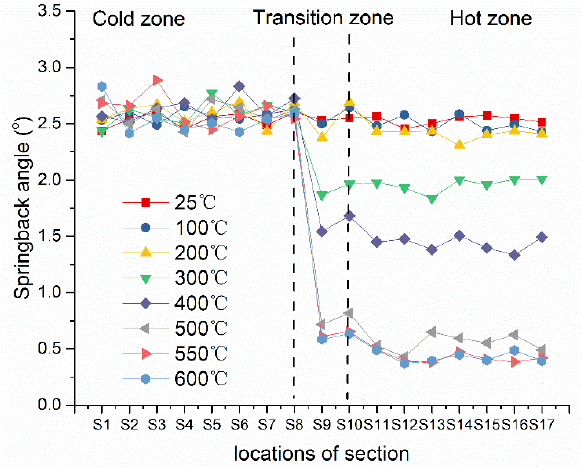
Figure 6. Springback angles under di ff erent heating tool temperatures.